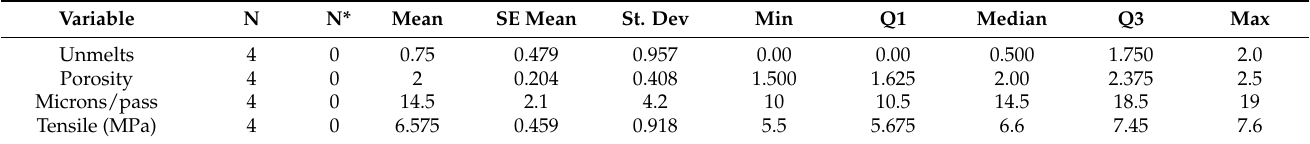
Figure 6. Histograms showing coating properties and the range of values that are expected (author’s own work). Table 2. Repeats of trials, to ensure that the outcome from the experiments is